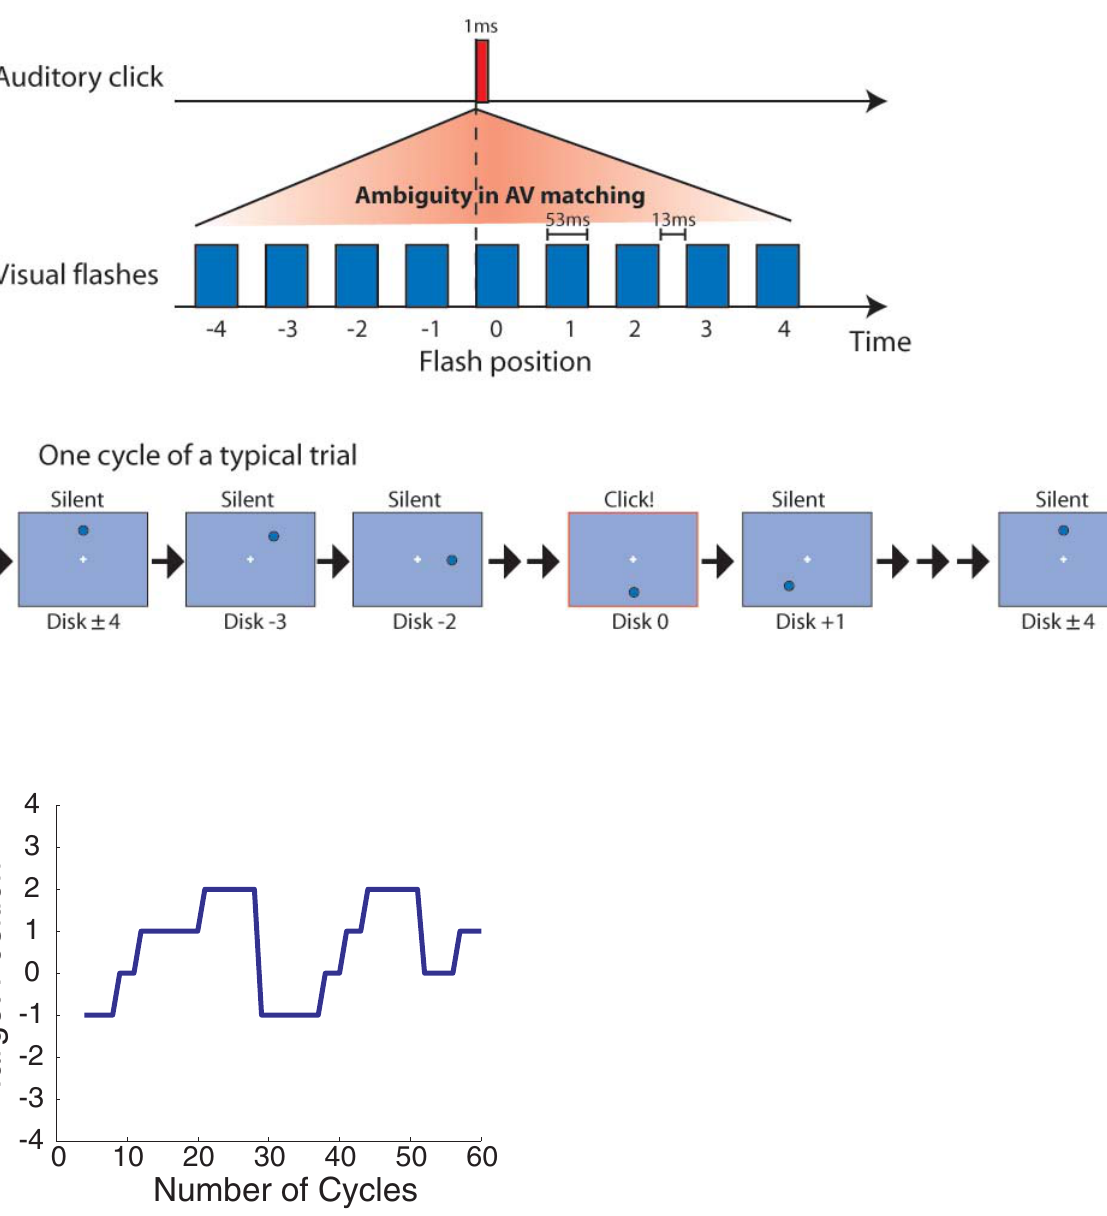
Figure 1. Multistability in AV temporal matching. A . Multiple visual flashes are presented in close temporal proximity to produce ambiguity in AV temporal matching. Many cycles were repeated continuously. B . A typical trial was illustrated. The visual flashes were presented at one of eight locations equidistant from fixation, producing the percept of a moving disk. One cycle lasted 534 ms. On a single trial, 60 identical cycles were repeated. C . The report of a representative trial is plotted as a function of stimulus